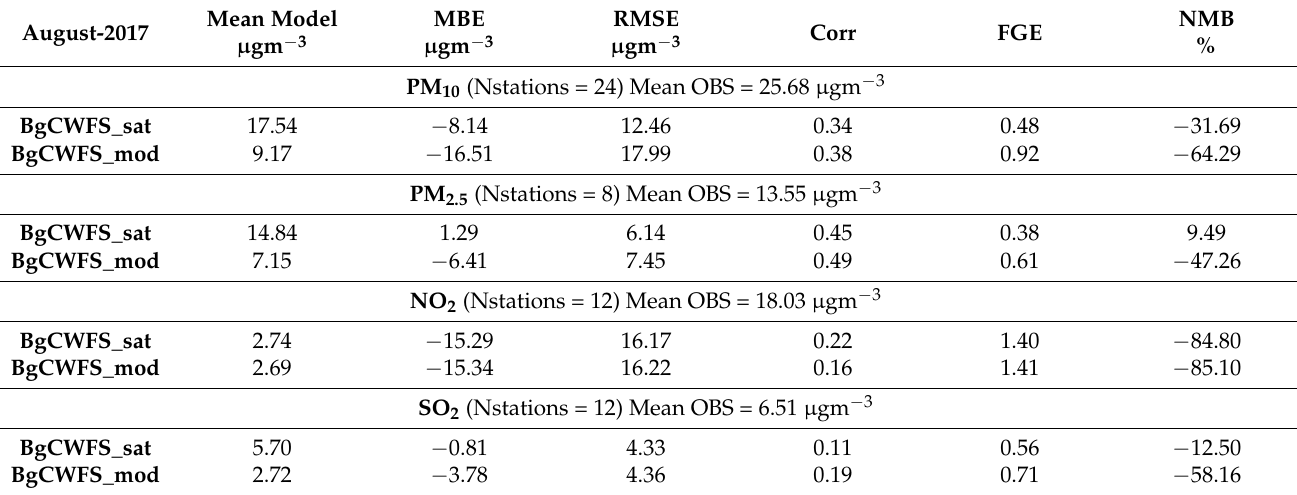
Table 1. Statistical parameters for BgCWFS results compared to surface observations in August 2017.